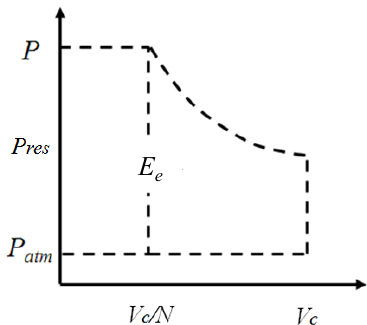
Figure 8. The ideal P-V diagram of the expansion